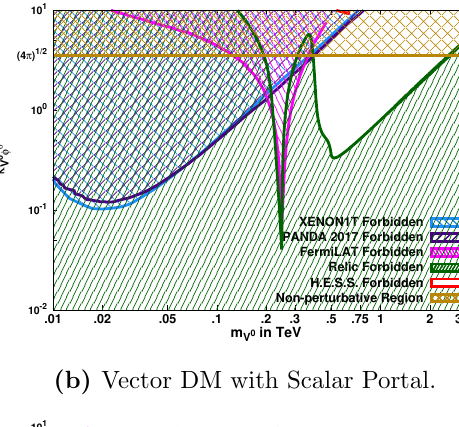
, (cid:17)(cid:30) 0